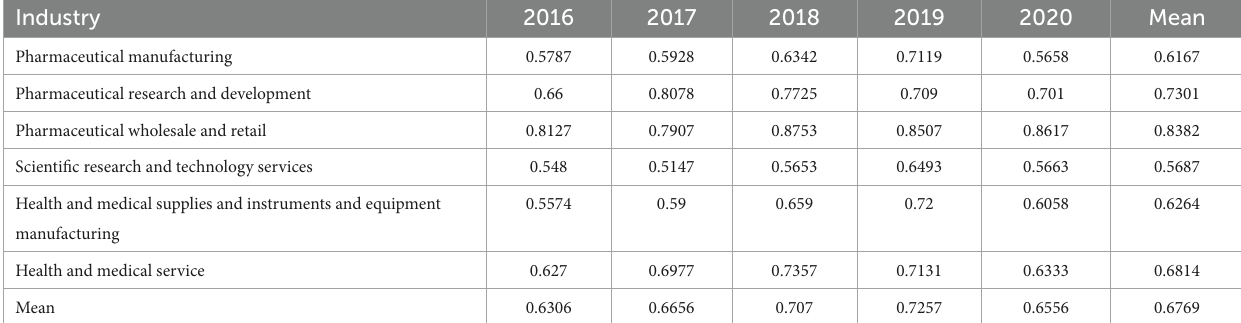
TABLE 5 The average innovation efficiency of listed companies in the health field by industry.